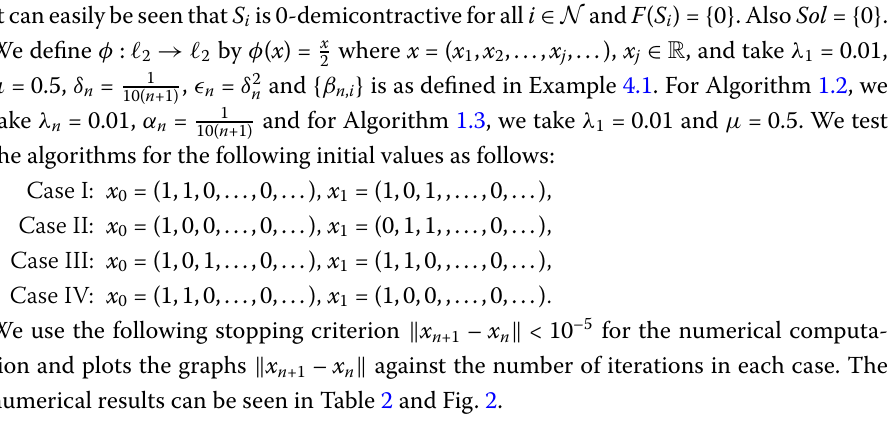
(cid:16) ∞ | x | 2 ) 1 2 , where x = j j =1